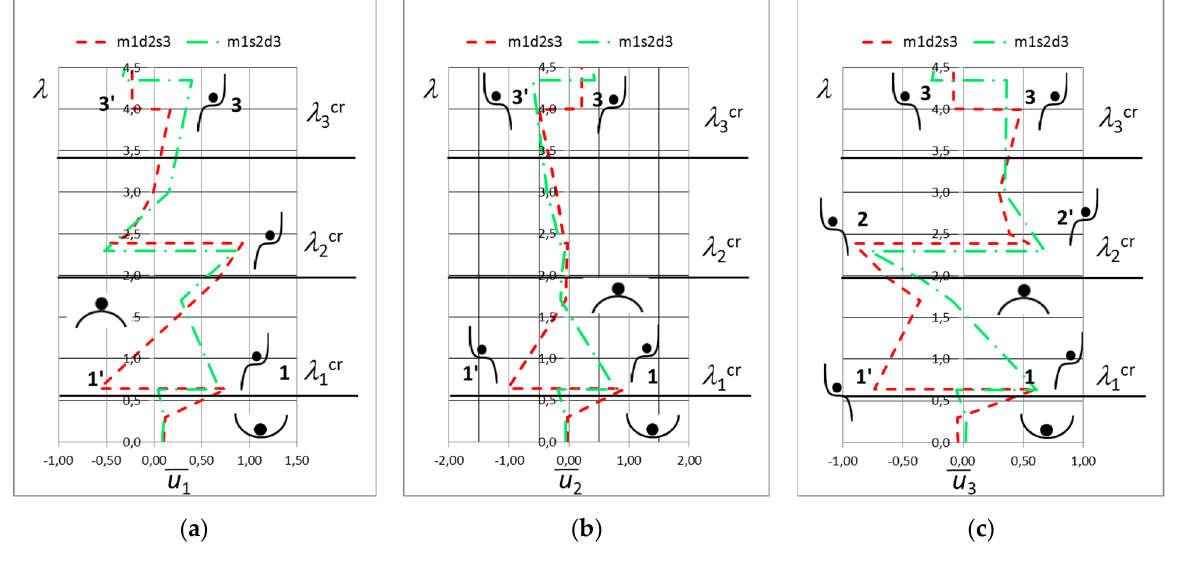
Figure 21. Equilibrium path obtained for geometrical imperfections in the shape of: small amplitude of the first buckling mode, medium or large amplitude of the second or third buckling mode, respectively ( m 1 d 2 s 3 lub m 1 s 2 d 3); displacement of the node: ( a ) No. 1, ( b ) No. 2, ( c ) No. 3.